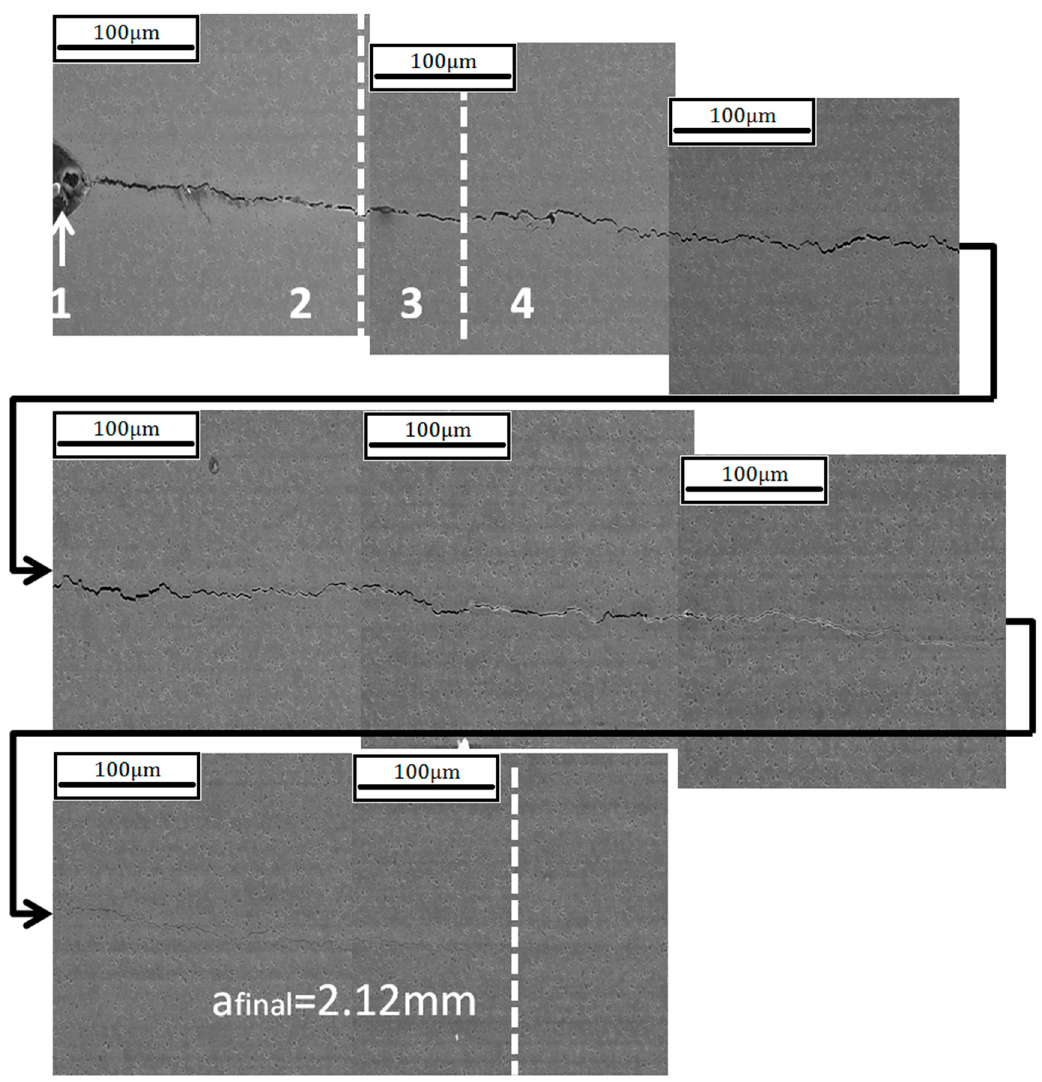
Figure 17. Crack progression of the 80 s 90° OOP ACW test.